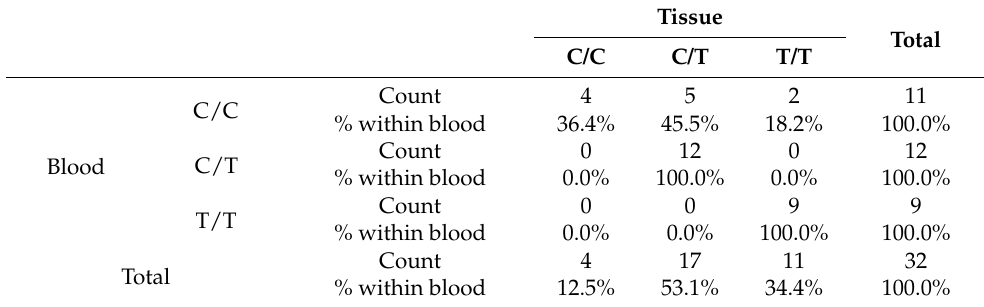
Table 7. Correlation between blood and tissue